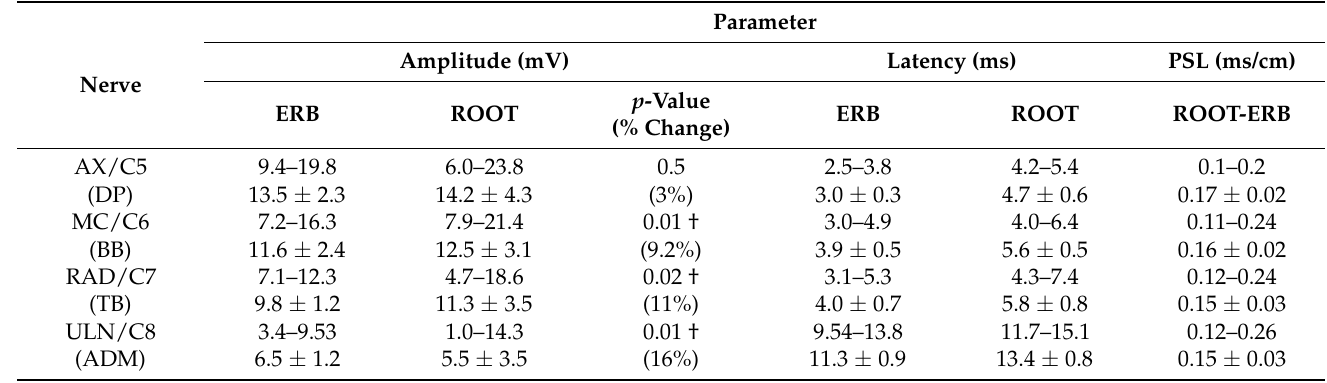
Table 5. Comparison of MEP parameters for stimulation at Erb’s point and cervical root. Ranges, means, and standard deviations are presented. Significant p -values at <0.05 are marked with † symbol.